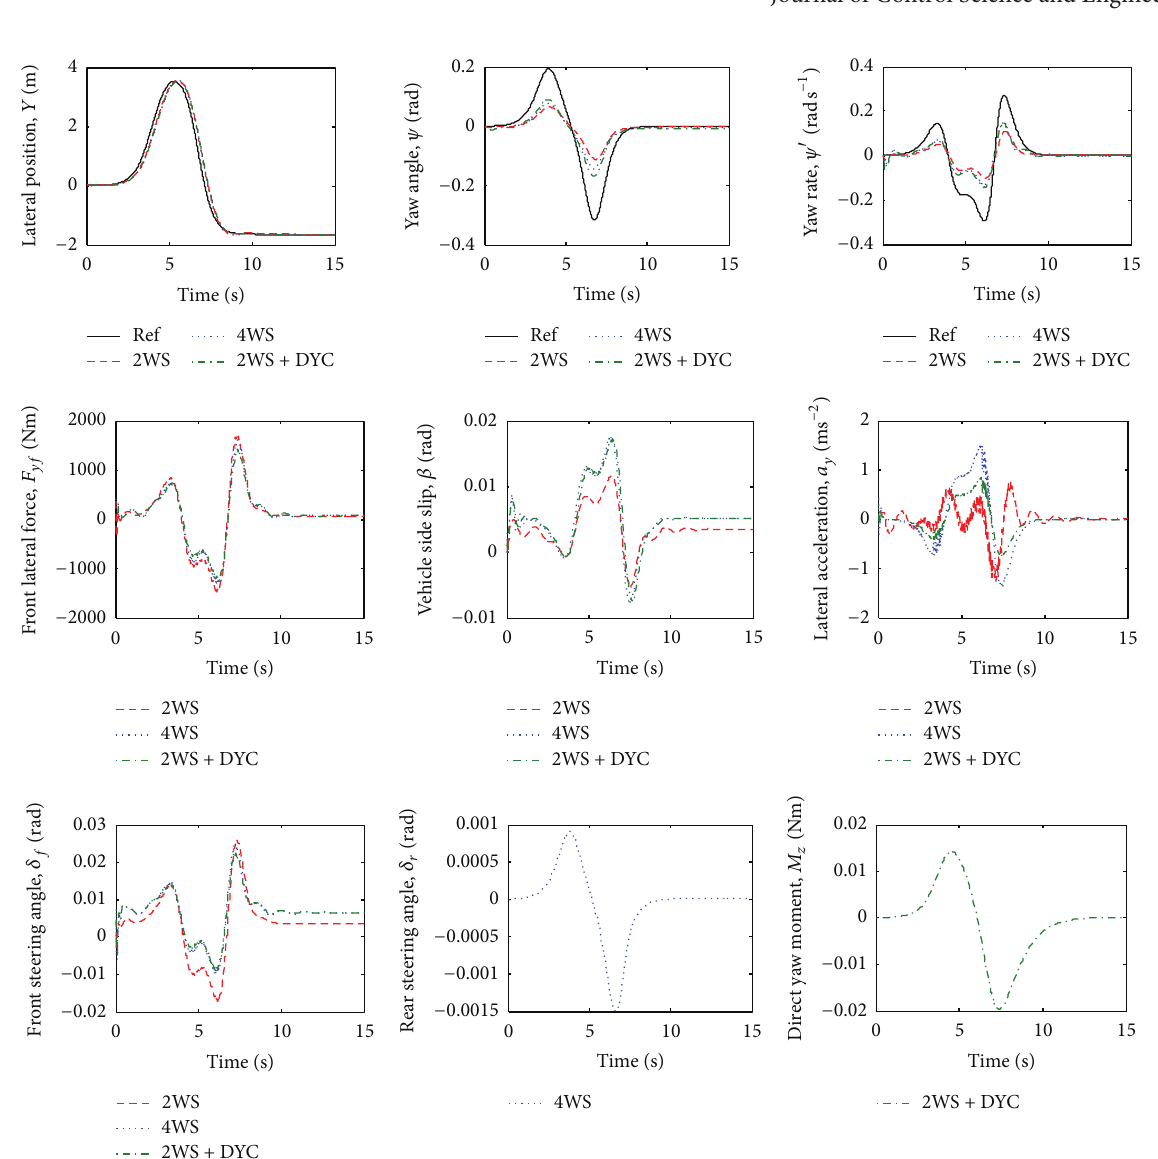
Figure 12: 2DoF controller at 30 ms −1 and 𝜇 = 0.7 by 2WS, 4WS, and 2WS +